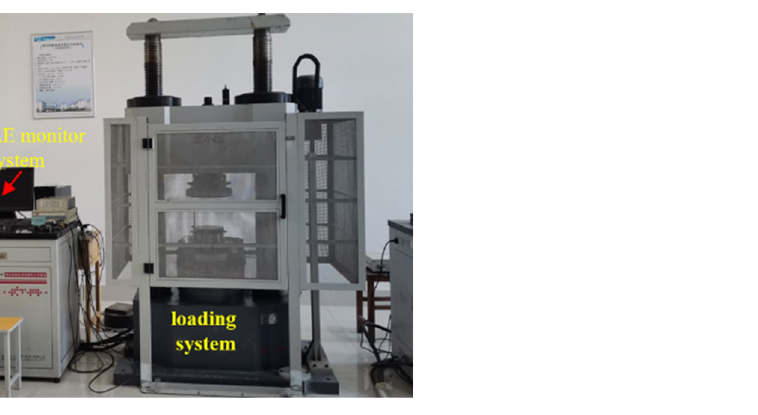
Figure 3. Schematic diagram of the test